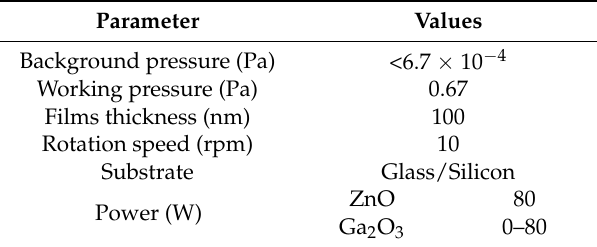
Table 3. Sputtering parameters maintained during the deposition of GZO thin